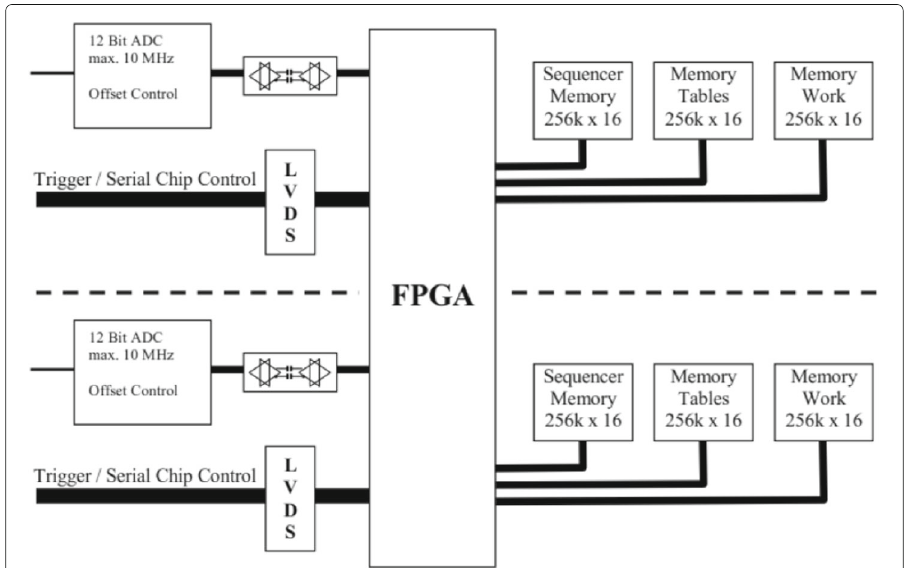
Fig. 17 Diagram of the Vertex